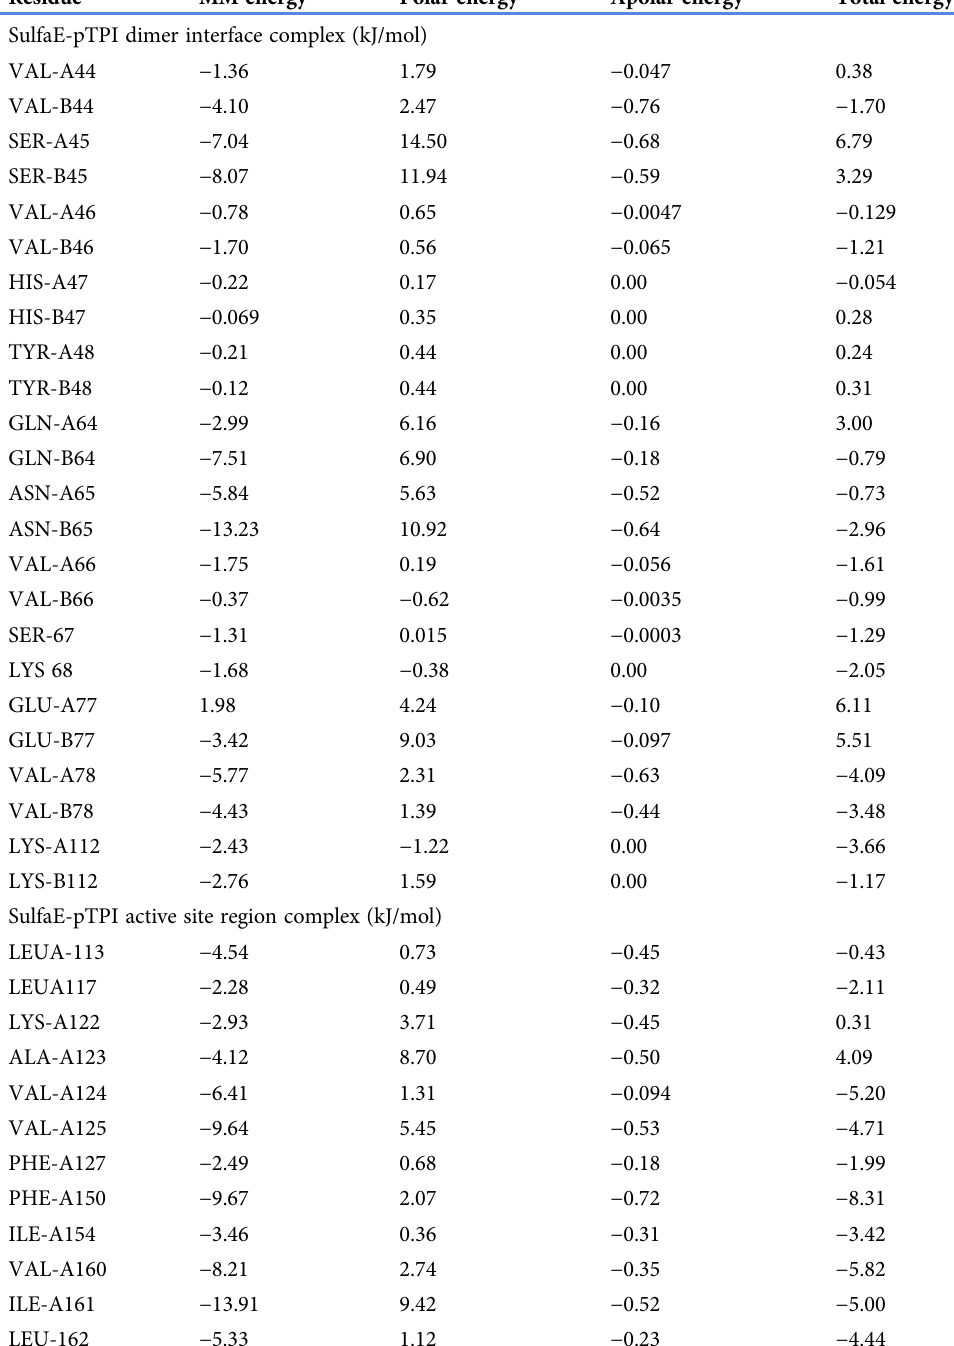
Table 4 Decomposition of Binding Free Energies Δ G (kJ/mol) for the four SulfaE − pTPI Complexes into Contributions from Individual